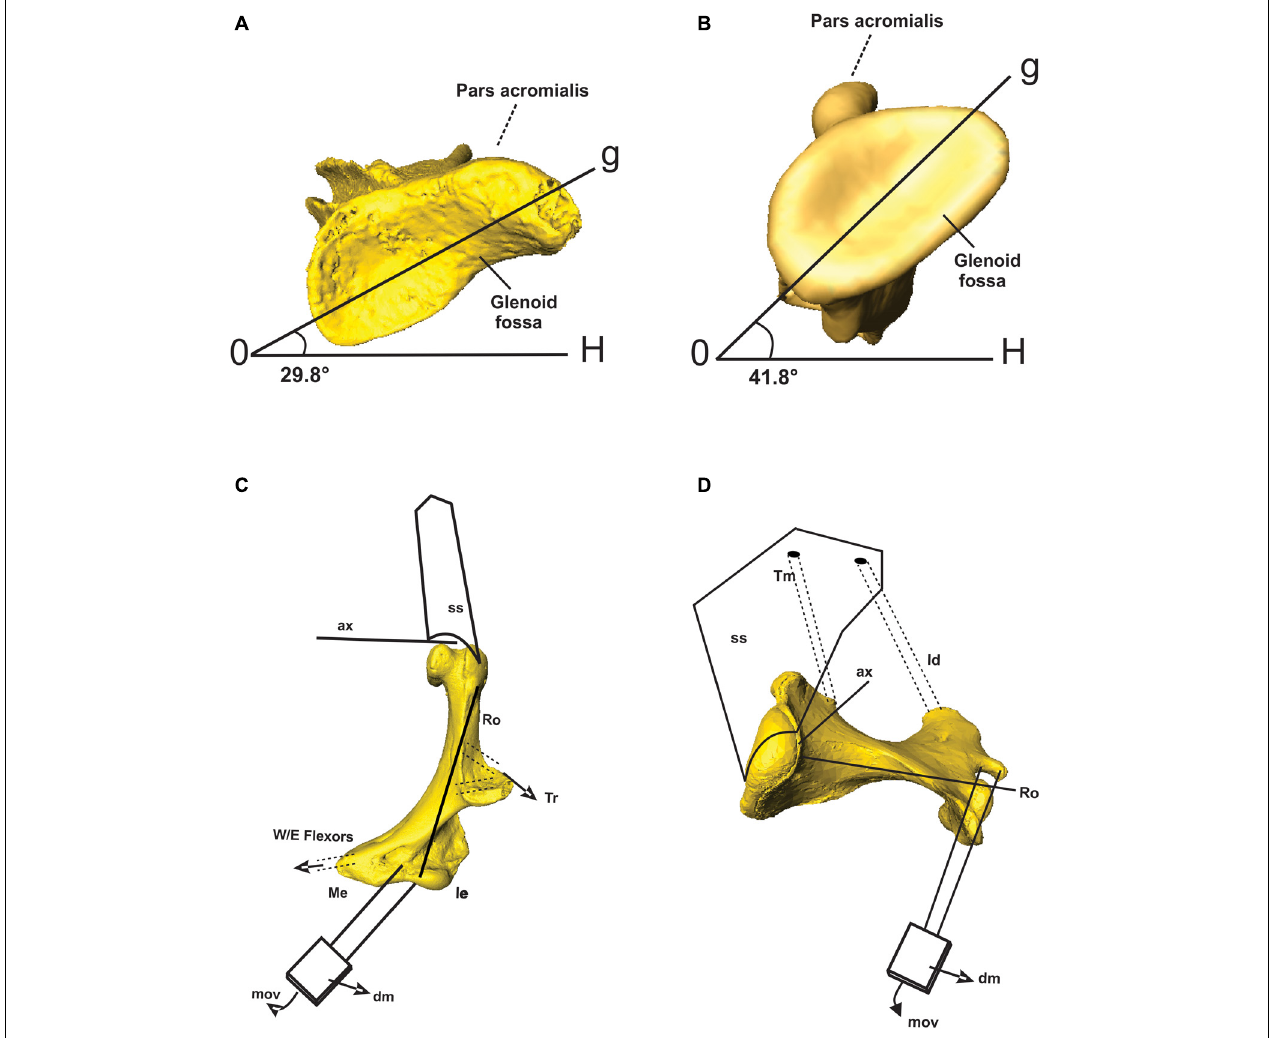
FIGURE 1 | Correlation between costal surface of the scapula and longitudinal axes of the glenoid fossa and functional context employed in the current study. (A) Naraboryctes philcreaseri (B) Talpa romana (C) Naraboryctes philcreaseri functional model (D) Tachyglossus aculeatus functional model. Abbreviation: H, costal surface; g, longitudinal axes of the glenoid fossa; ax, retraction axis; ss, scapula; ro: rotational axis; Tr, m. triceps; Me, medial epicondyle; Le, lateral epicondyle; W/E Flexors, wrist and elbow flexors muscles; dm, dorsal manus; mov, movement direction; ld, m. latissimus dorsi; Tm, m. teres